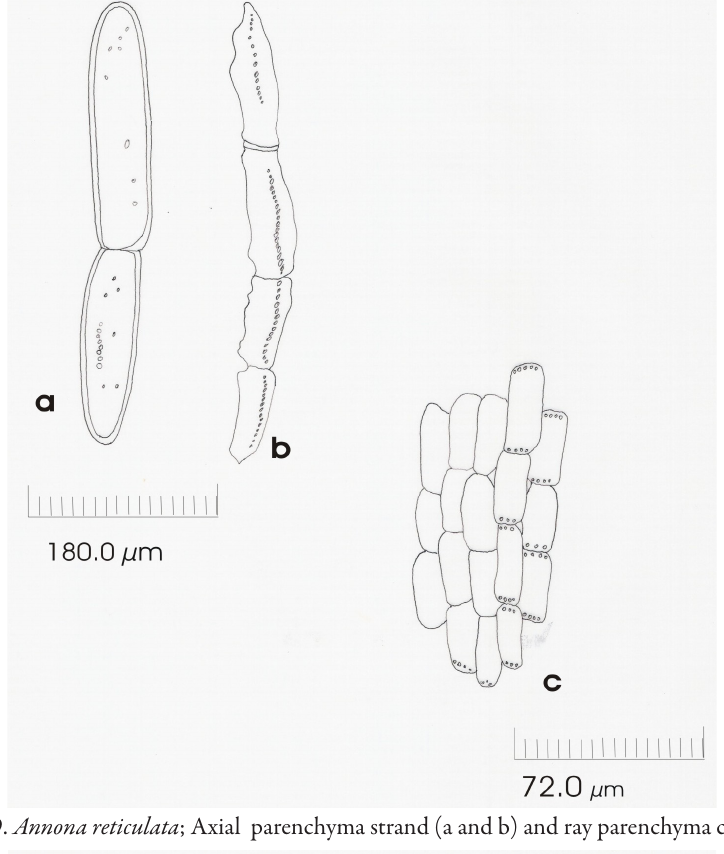
Fig. 9. Annona reticulata ; Axial parenchyma strand (a and b) and ray parenchyma cells (c)